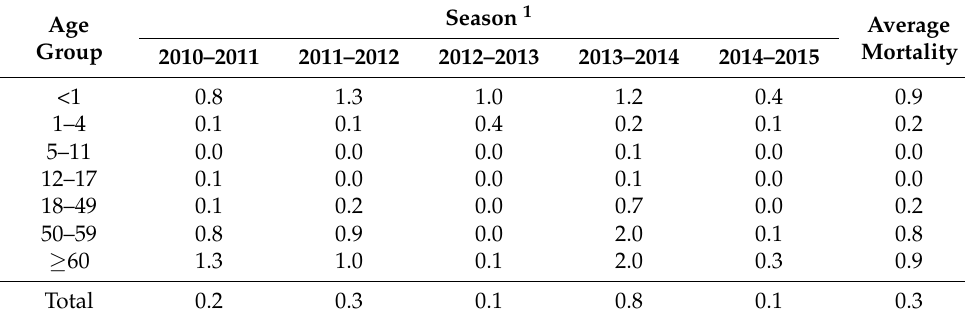
Table 5. Mortality by age group and season (per 100,000 inhabitants).